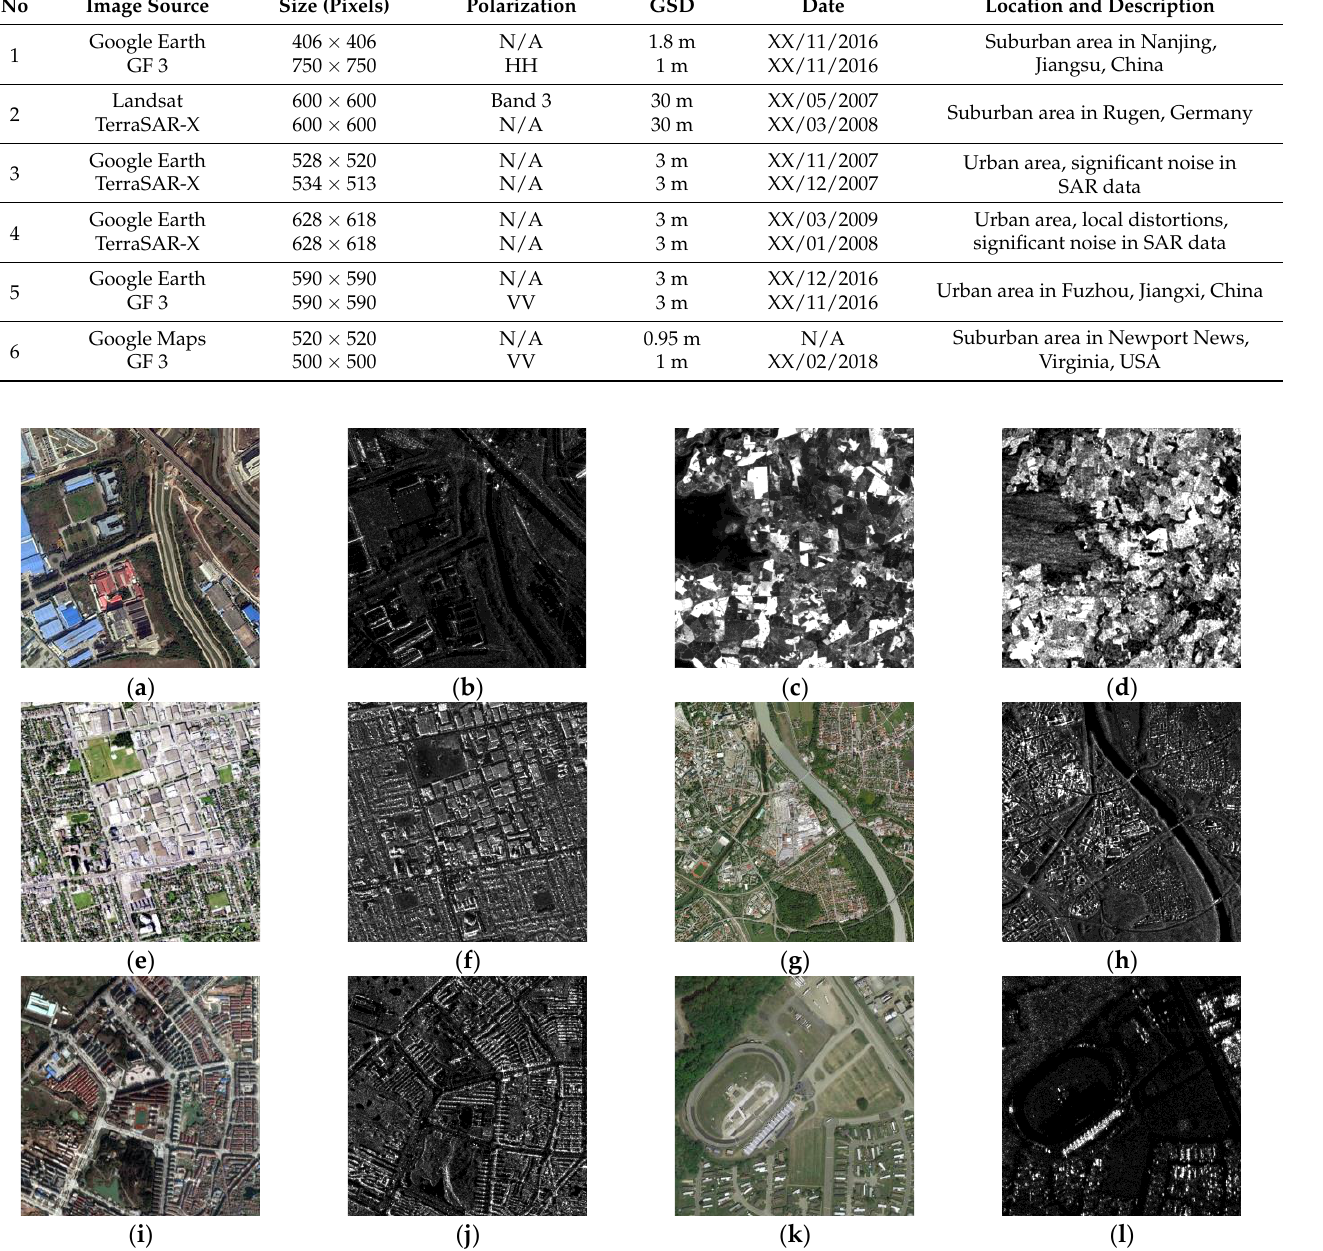
Figure 8. Six image pairs:( a ) Google Earth and ( b ) GF 3; ( c ) Landsat and ( d ) TerraSAR-X; ( e ) Google Earth and ( f ) TerraSAR-X; ( g ) Google Earth and ( h ) TerraSAR-X; ( i ) Google Earth and ( j ) GF 3; ( k ) Google Maps and ( l ) GF 3. Table 1. Details of the experimental data.